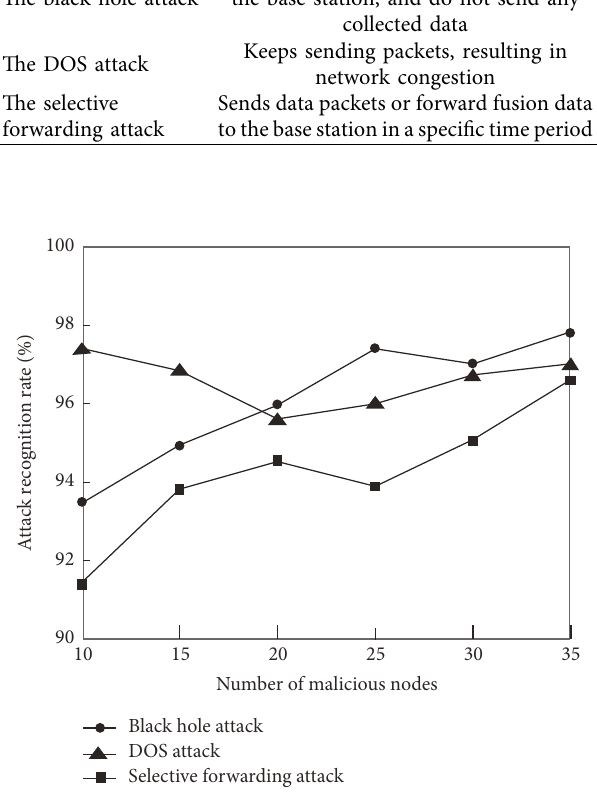
Figure 4: Relationship between number of malicious nodes and recognition rate.